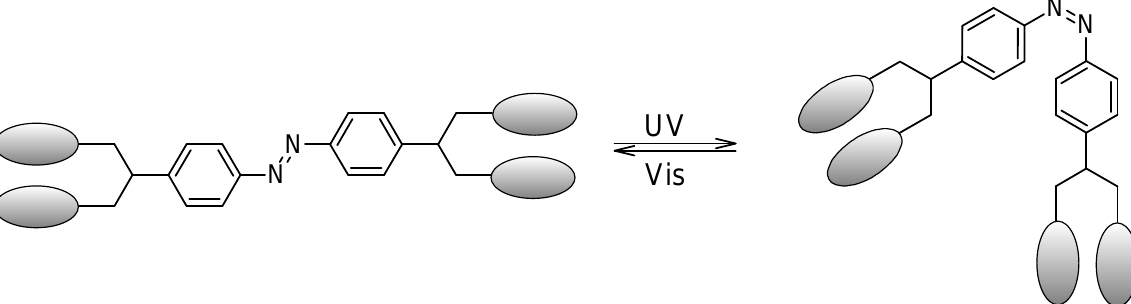
Figure 10. Schematic isomerization of multivalent sugar ligand azobenzene. The elliptic drawings represents the sugar moieties.